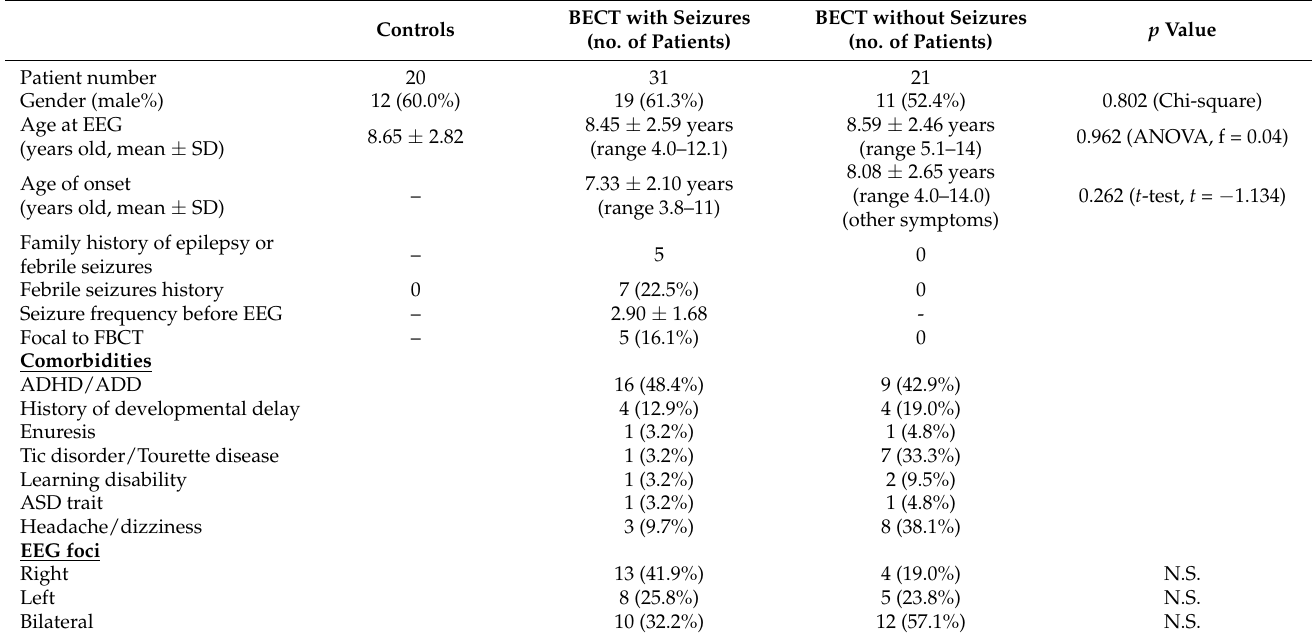
Table 1. Clinical demographics in children with benign childhood epilepsy with centrotemporal spikes (BECT) with or without behavior seizures before